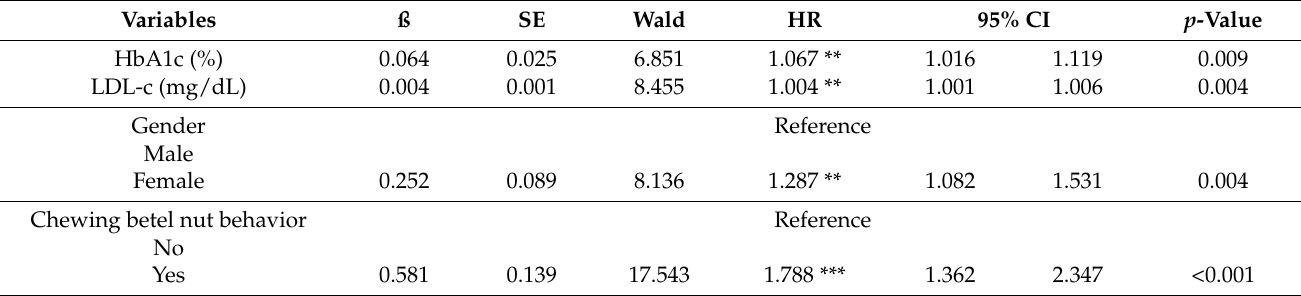
Table 3. A Cox proportional hazard model for risk factors of DR in patients with T2DM (N =